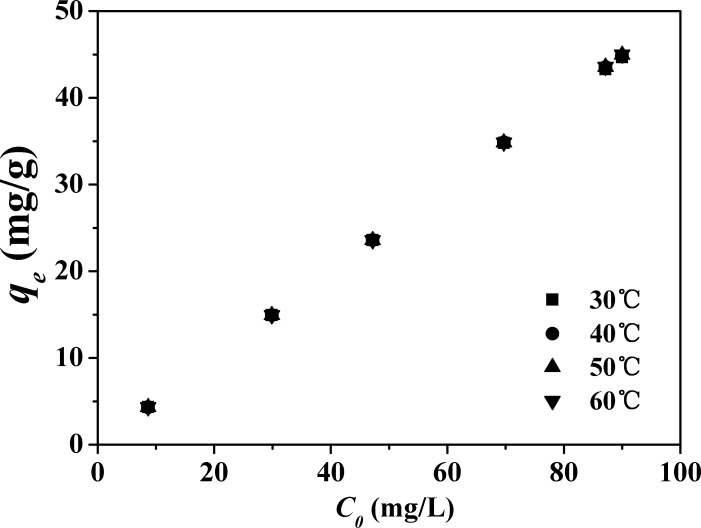
Effect of temperature on the adsorption of Co2+ by APTES3.0CEC-Mt.